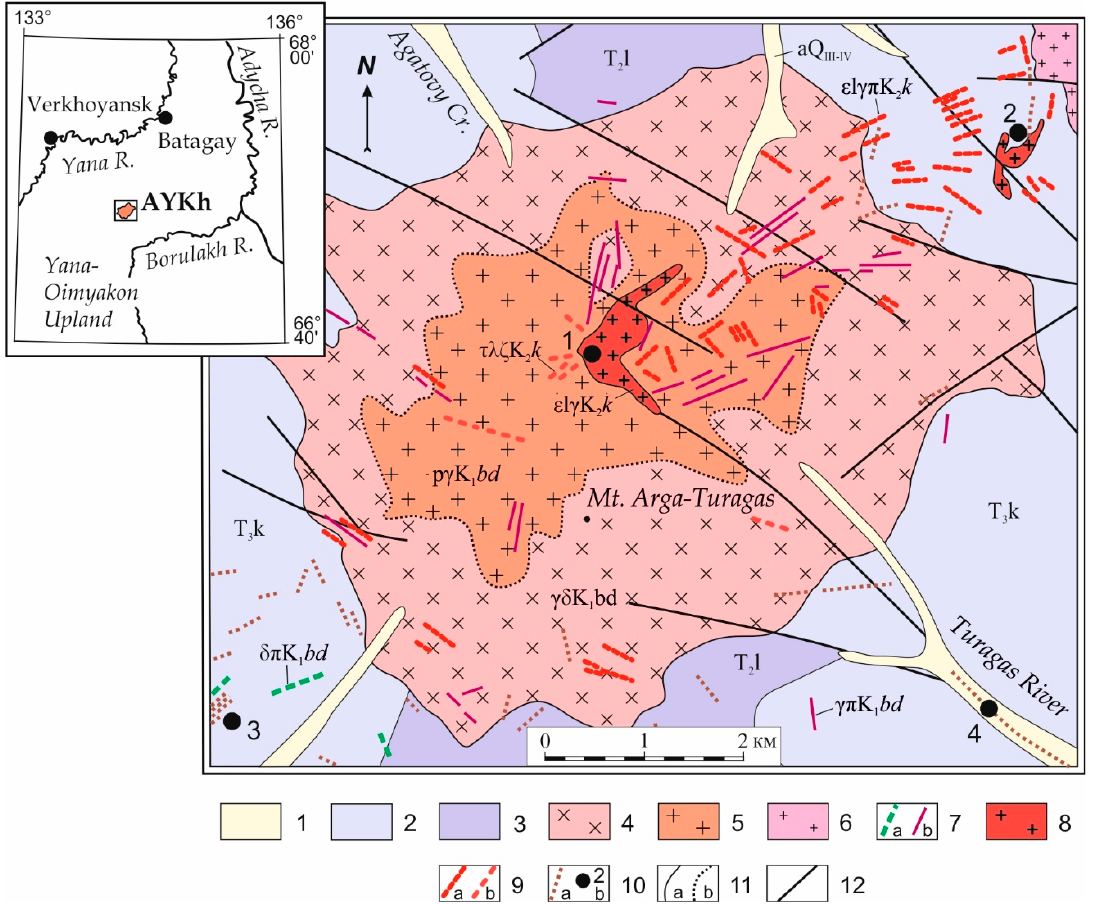
Figure 1. Geological map of the Arga Ynnakh Khaya pluton: (1) Alluvial and talus solifluction boulder–pebble sediments, gravels, sand, and loamy sands (aQ III-IV ). (2) Carnian sandstones and siltstones (T 3 k). (3) Ladinian siltstones and sandstones (T 2 l). (4–7) Baky-Derbeke Complex: (4) main granodiorite ( γδ K 1 bd ), (5) main andesine granite (p γ K 1 bd ), (6) biotite, two-mica granites, and leucogranites ( γ K 1 bd ), (7) dikes of (a) diorite–porphyrite ( δπ K 1 bd ) and (b) granite–porphyry, leucogranite–porphyry, and aplite ( γπ K 1 bd ). (8,9) Kester Complex: (8) fine- to coarse-grained albite